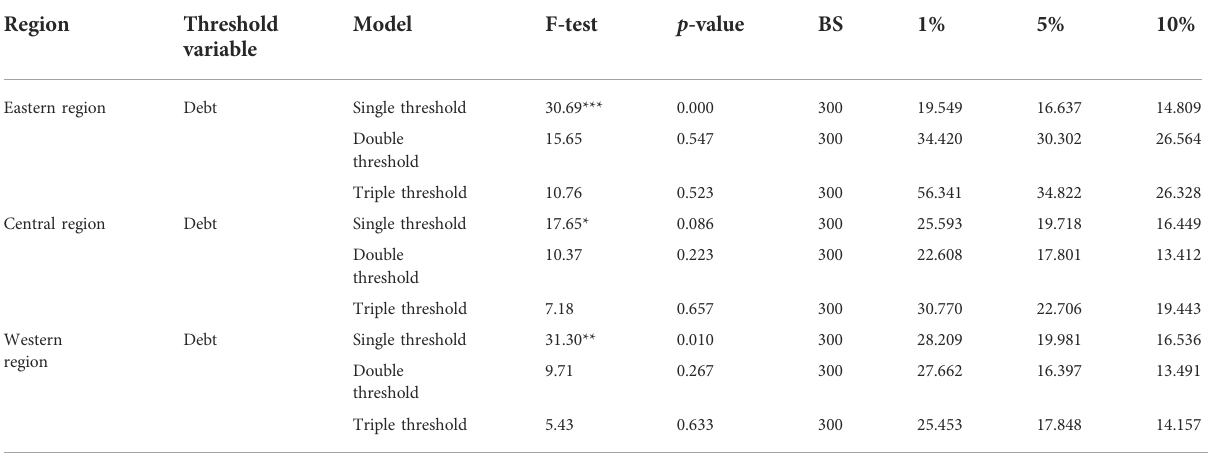
TABLE 9 The existence test of threshold effect in three regions.